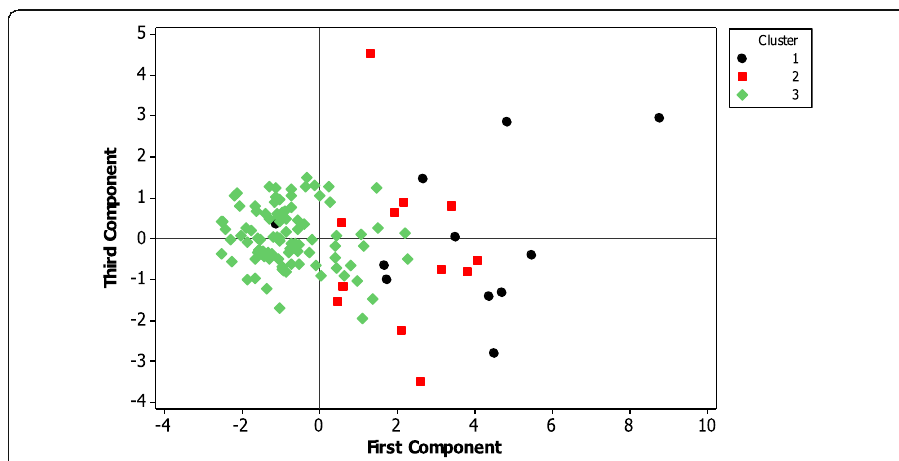
Fig. 4 Score plot for principal components 1 and 3 from PCA. Clusters from the hierarchical ascending classification are shown in black (cluster 1), red (cluster 2), and green (cluster